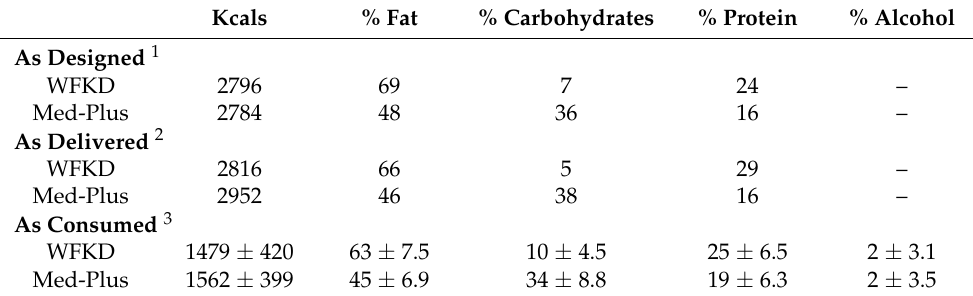
Table 3. Macronutrients of Foods as Designed, as Delivered, and as Consumed During Food Delivery Component of the Keto–Med Randomized